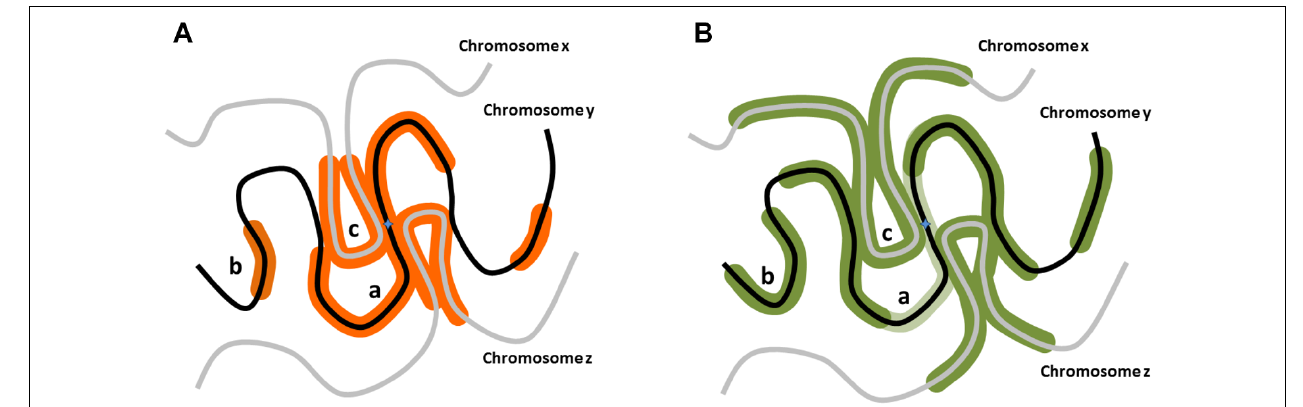
(B) RNF168 polyubiquitylation-dependent 53BP1 distribution could exhibit distribution analogous to γ H2AX, but potentially more expanded distally from the break site. Notably, in G2 stage of the cell cycle in particular, 53BP1 distribution pattern may be only partially overlapping with the γ H2AX region as it is excluded from the vicinity of the break site bound by BRCA1 (light green; Chapman etal.,